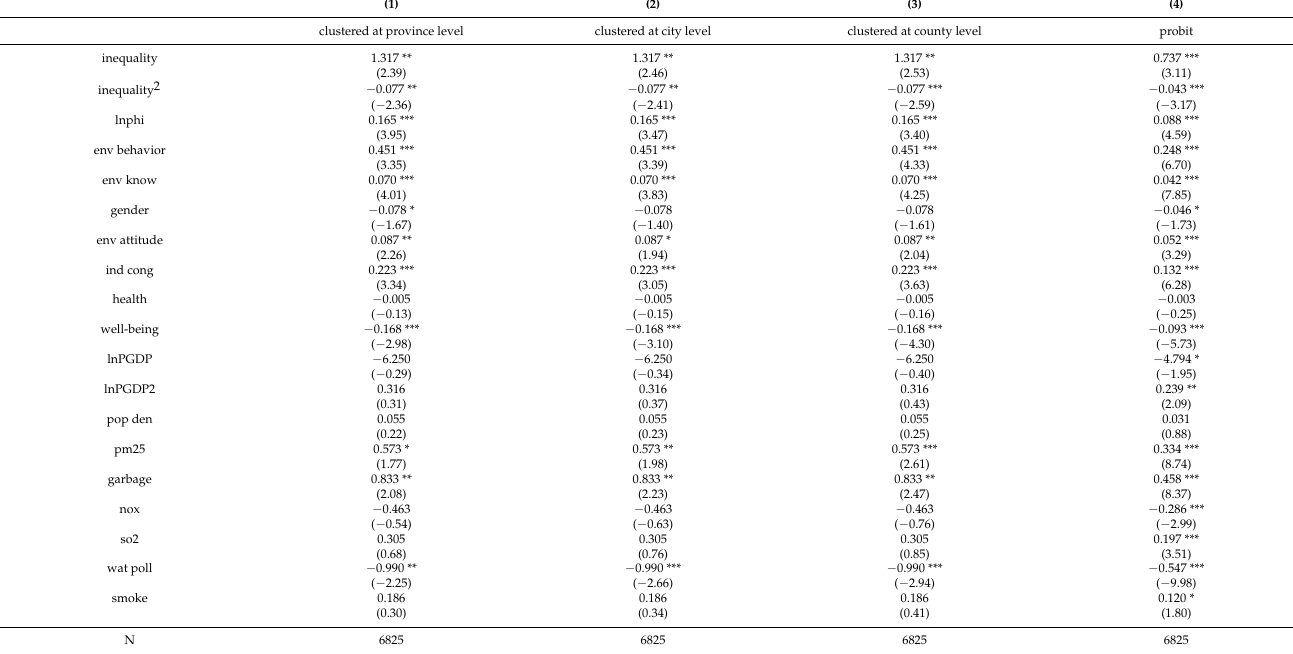
Table A8. The effect of individual-level income inequality on subjective environmental pollution: robustness test based on cluster analysis and an ordered probit